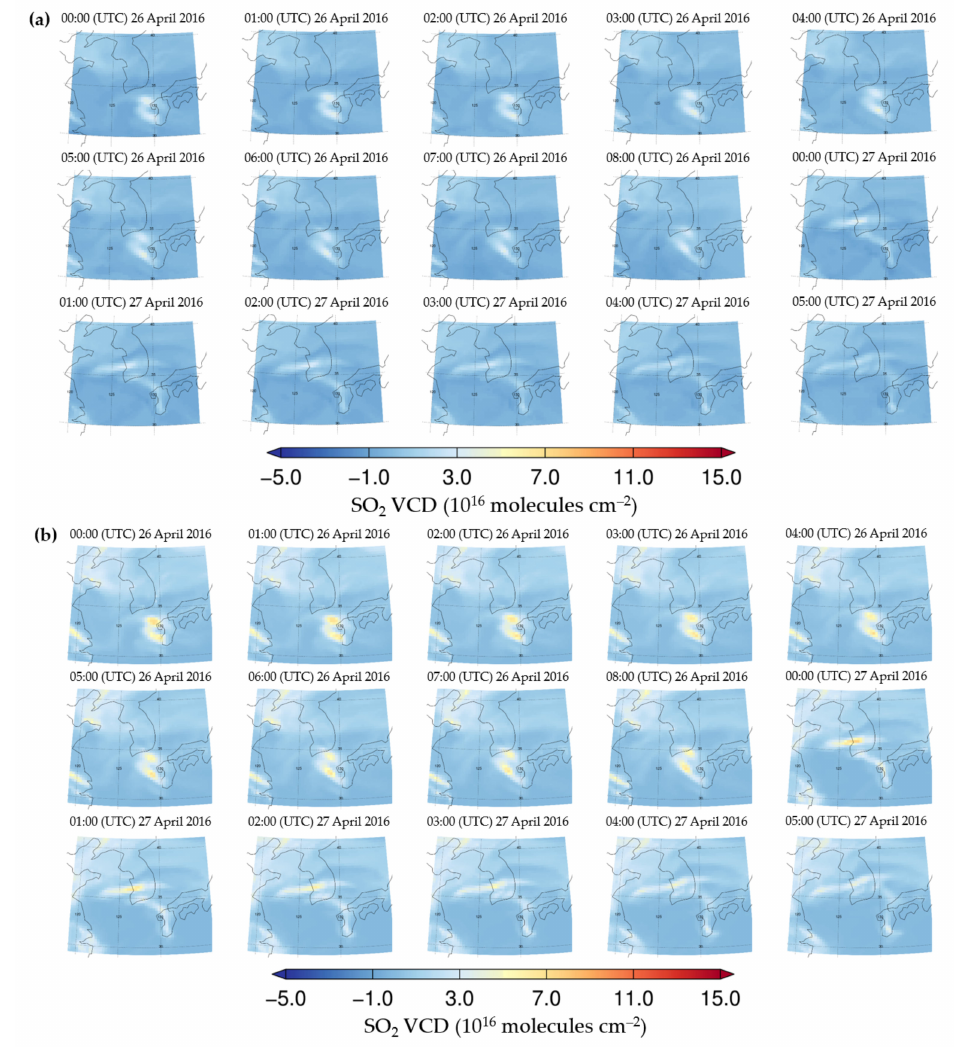
Figure 10. Examples of SO 2 VCDs retrieved from ( a ) GEMS synthetic radiances and ( b ) true SO 2 VCDs on 26–27 April